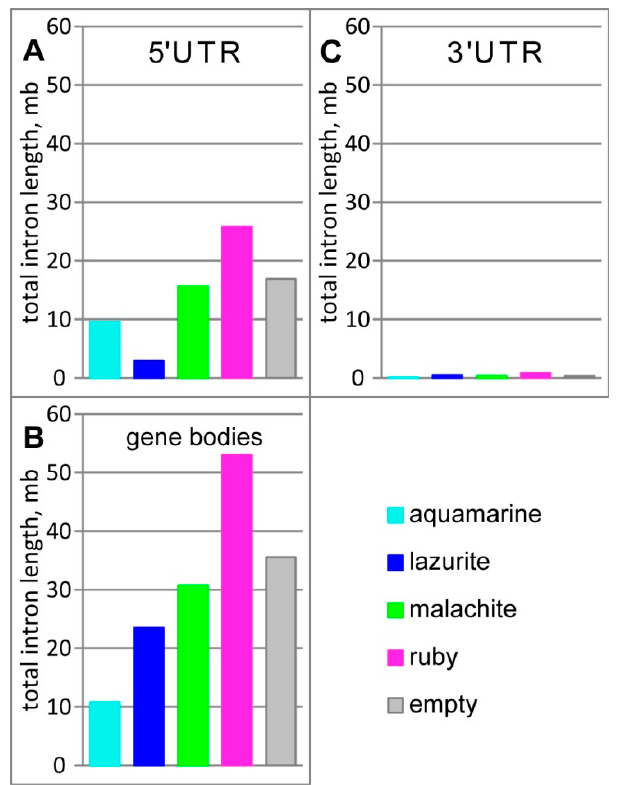
Figure 4. Summed intron length (Mb) overlapping with four-chromatin states model [39]. (A) in 5’UTR; (B) in gene bodies; and, (C) in 3’UTR.